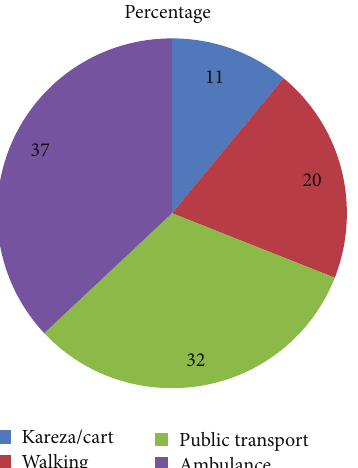
Figure 1: Mode of transportation used by clients to reach facilities where they received delivery care service in public facilities of Gamo Gofa Zone, December 17, 2013, to January 27, 2014.